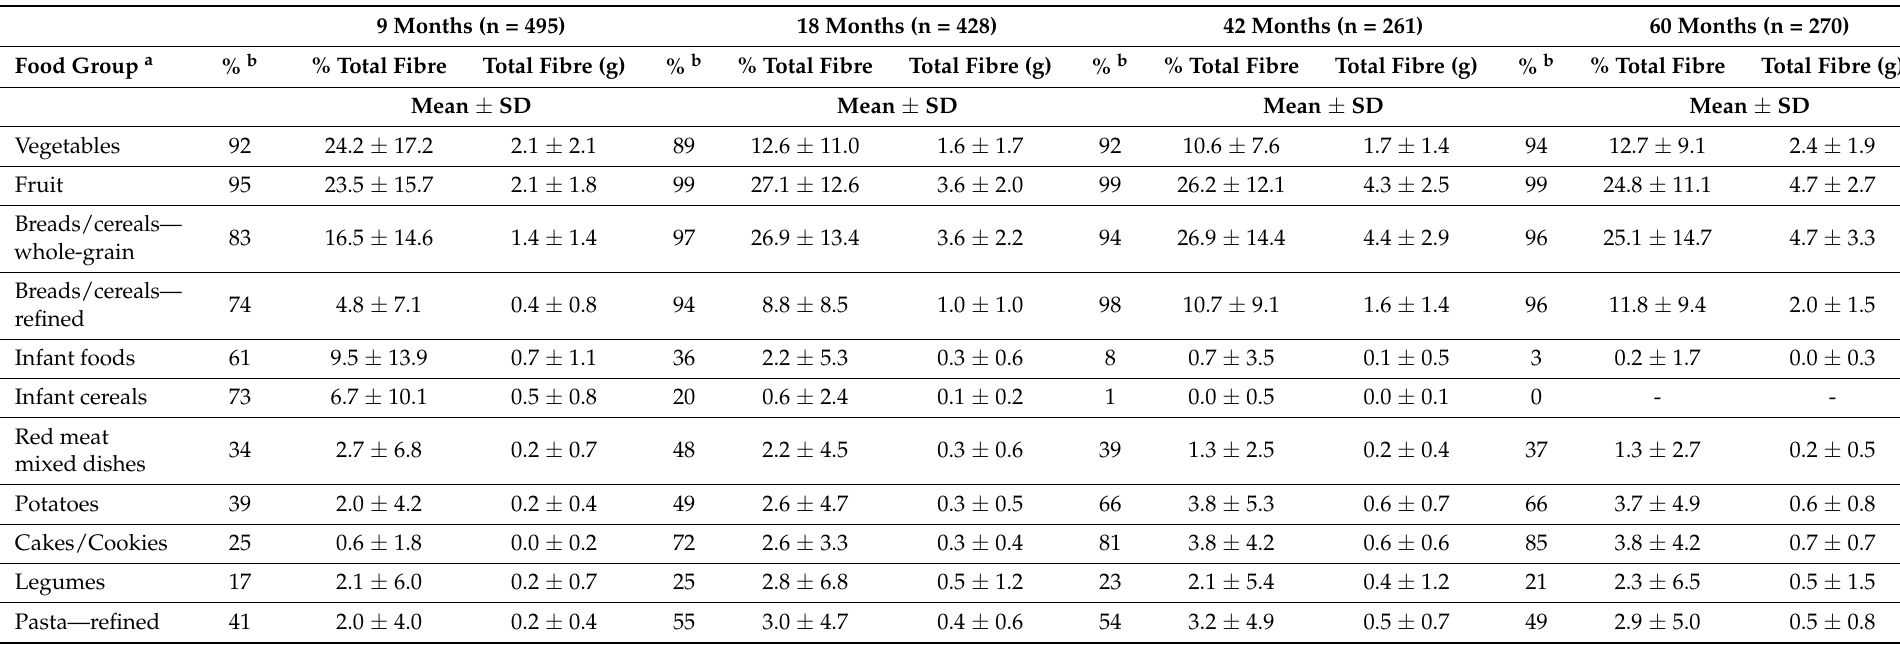
Table 3. Main fibre food sources at ages 9, 18, 42, and 60 months in the Melbourne Infant Feeding Activity and Nutrition Trial